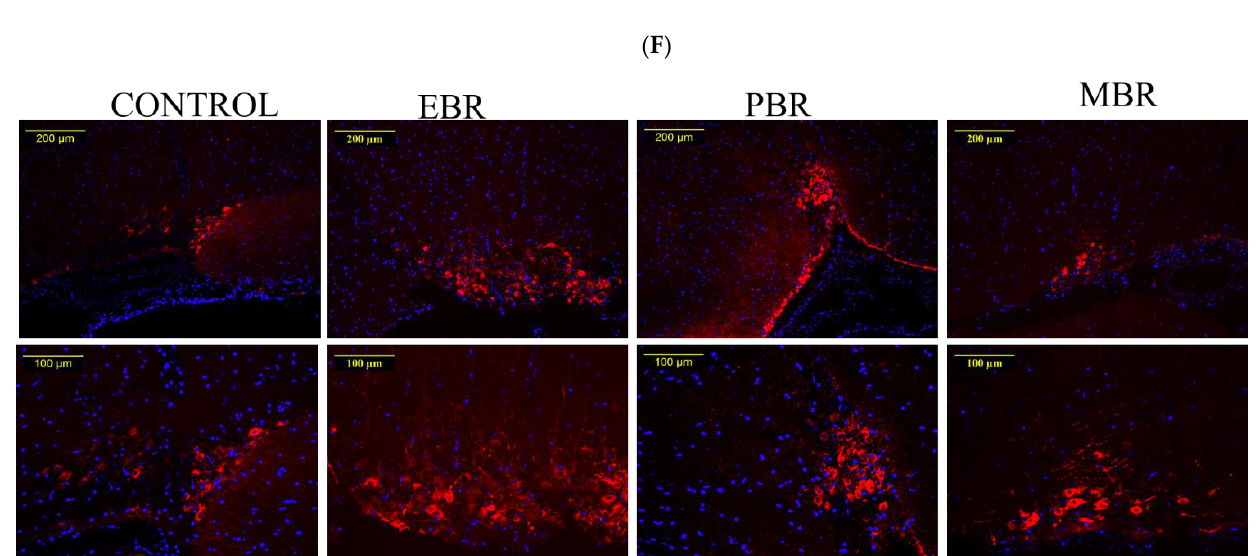
Figure 8. Brain AVP levels 8 days post-PSS exposure. Immunohistochemistry of AVP 8 days post-PSS exposure. ( A ) Levels of AVP in overall fibers in the PVN. ( B ) Levels of AVP in the overall cells of the Supraoptic nucleus. ( C ) Levels of AVP in magnocellular neurosecretory cells in the PVN. ( D ) Levels of AVP in magnocellular neurosecretory cells in the PVN. Significant values are shown in the graphs. Panel ( E ) shows a schematic drawing of the region of the SON from which the measurements were collected. ( F ) Representative images of AVP-immunoreactivity in the SON region of CONT, EBR, PBR, and MBR groups are also shown. Images were acquired at 10 × magnification. Scale bar: 200 µ m. The cells in red are MR-positive.